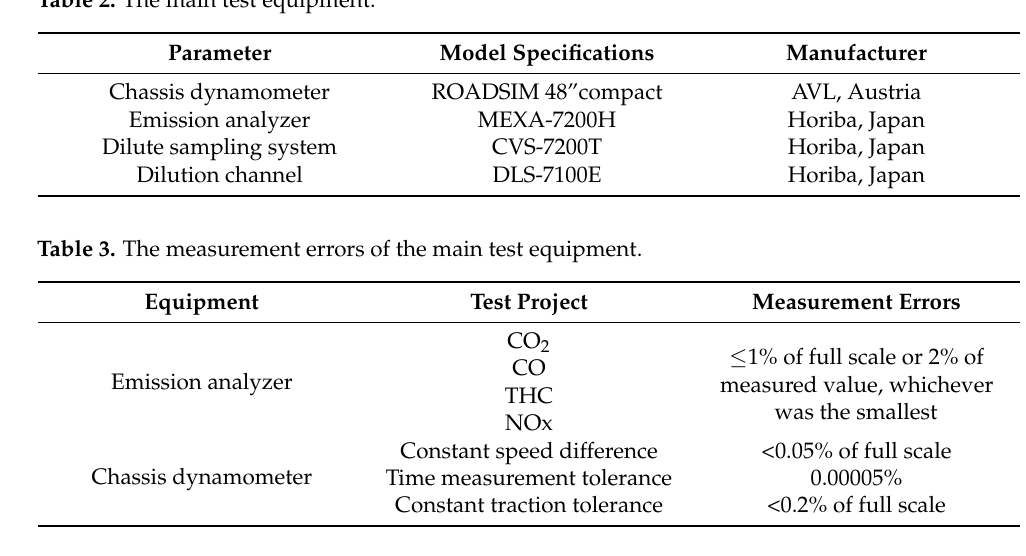
Figure 1. The schematic diagram of the chassis dynamometer test bench. Table 2. The main test equipment.